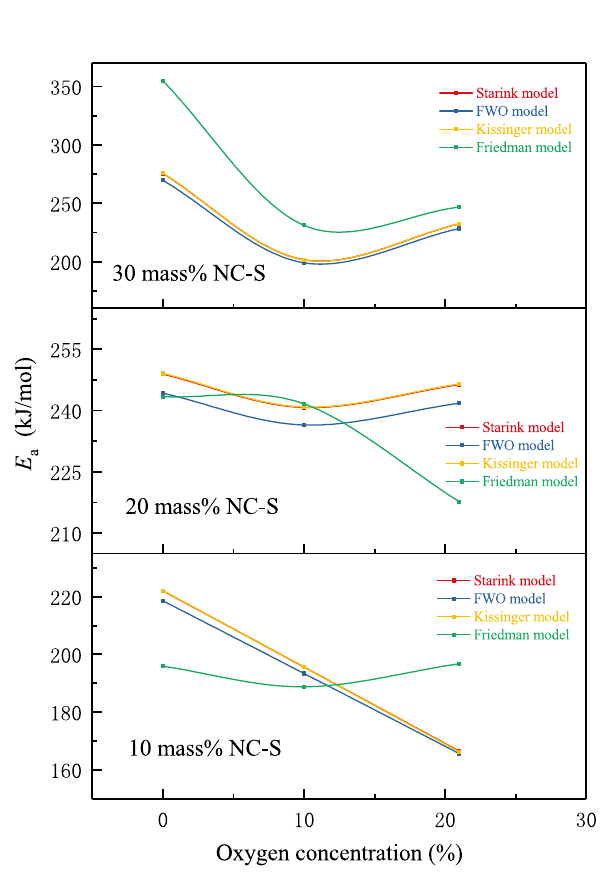
Figure 6. NC-S’s E a under three different atmosphere conditions calculated by four kinetic models with TG